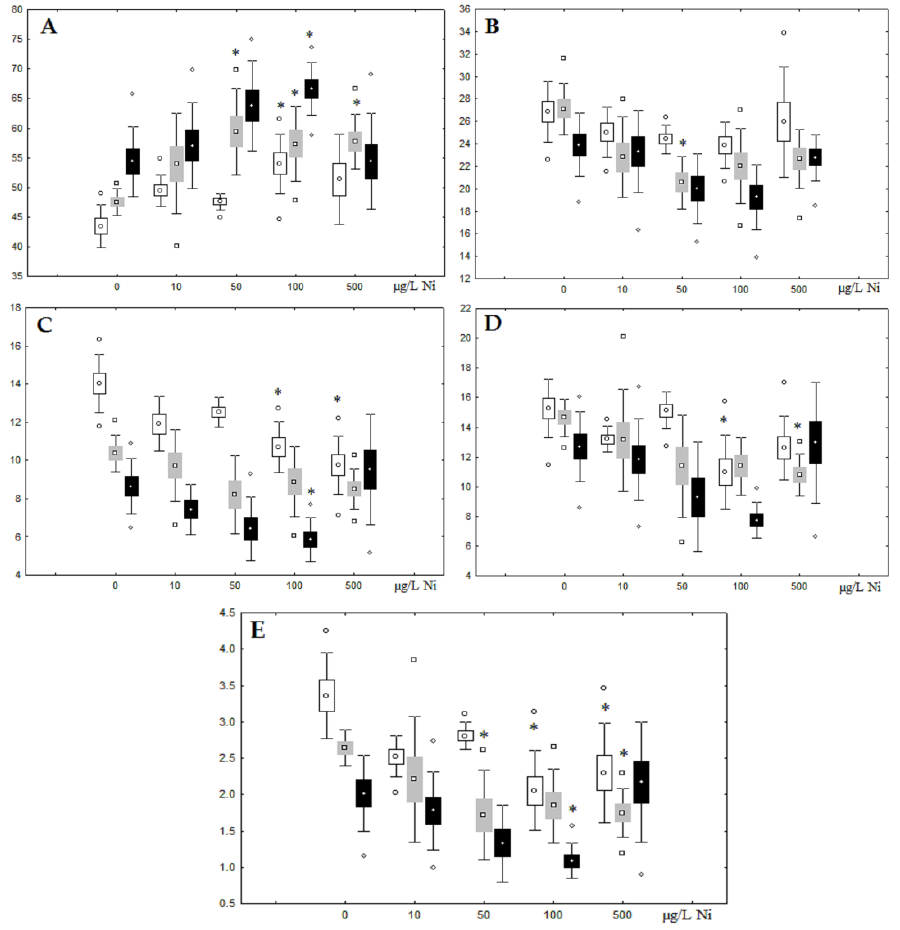
Figure 4. Changes in the ( A ) sum of saturated fatty acids, ( B ) monounsaturated fatty acids, ( C ) n-3 polyunsaturated fatty acids, ( D ) n-6 polyunsaturated fatty acids, and ( E ) unsaturation index in triacylglycerols of digestive glands of A. cygnea under experimental nickel effects: white box – day 1 of the experiment; grey box – day 3 of the experiment; black box – day 7 of the experiment. * – significant results in comparison with control (0 µg/L Ni). Differences were estimated using the nonparametric Kruskal – Wallis test; p < 0.05.